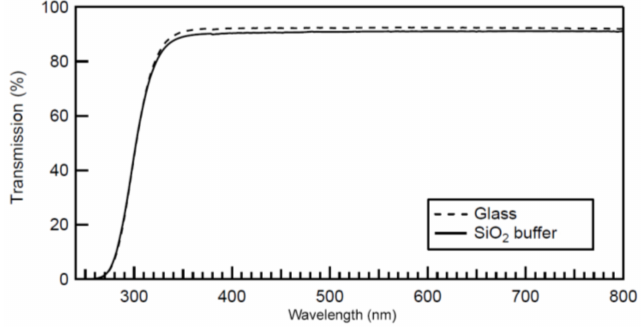
Figure 3. UV-Vis transmission spectrum of a silica buffer layer coated on a standard microscopy glass